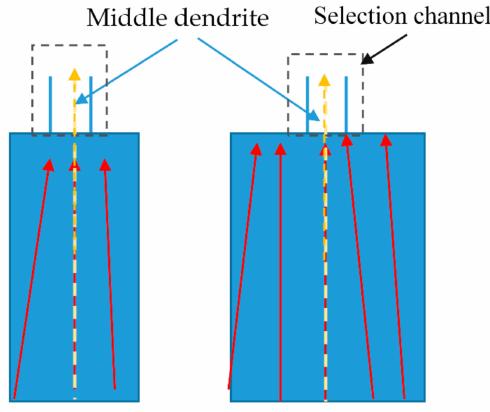
Figure 4. Grain growth direction in the start